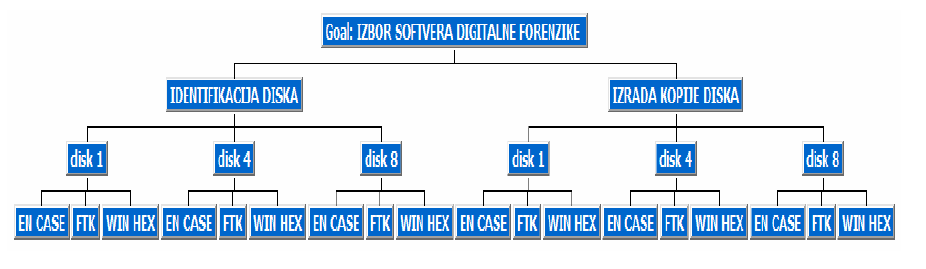
Figure 2 – Hierarchical structure of the problem of digital forensics software selection Рис . 2 – Иерархическая структура проблемы выбора программного обеспечения цифровой форензики